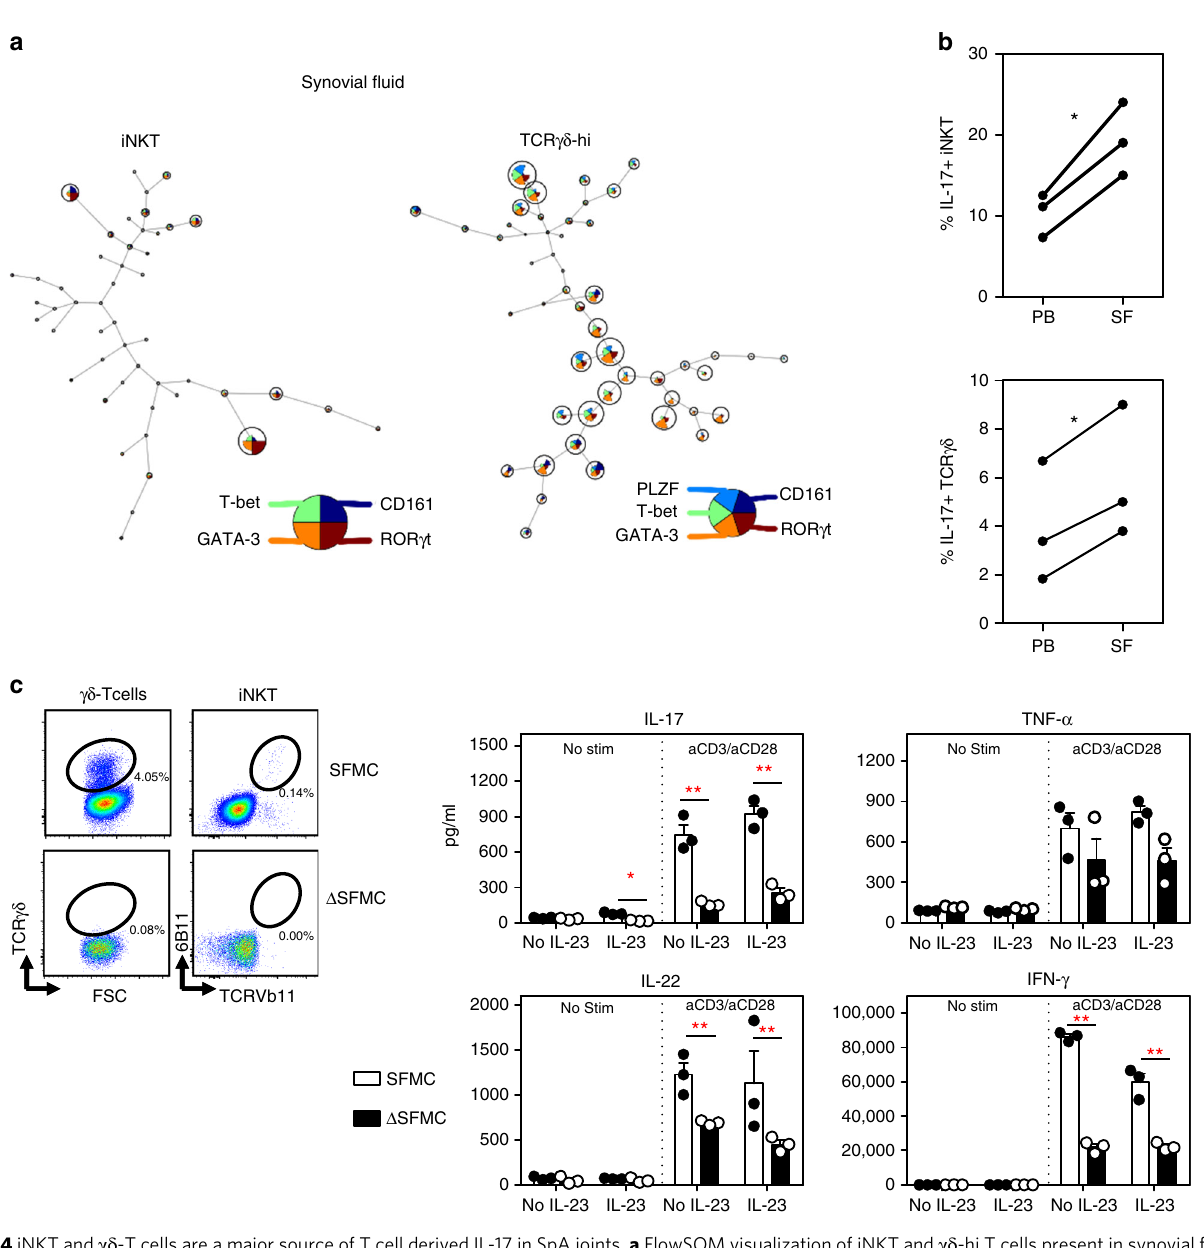
Fig. 4 iNKT and γδ -T cells are a major source of T cell derived IL-17 in SpA joints. a FlowSOM visualization of iNKT and γδ -hi T cells present in synovial fl uid samples from three treatment naïve SpA patients, stained for the indicated markers set (as explained in Fig. 3F). Nodes show cell subsets (including ROR γ t + cells) enriched in the synovial fl uid (compared to cells from paired blood samples). Other subsets (nodes) are present but at a relatively lower frequencies. b Paired analyses of IL-17 production by SpA SF and blood derived iNKT and γδ -T cells as determined in Fig. 3G. (* p < 0.05, paired t -tests). c Synovial fl uid derived mononuclear cells (SFMC) and SFMC cells depleted of iNKT and TCR γδ cells ( Δ SFMC, illustrated in the plots) were cultured in the presence or absence of IL-23 combined with or without aCD3Ab/aCD28Ab stimulation. Supernatants were collected at 72 h of culture and cytokines production was measured by ELISA (SFMC vs. Δ SFMC; * p < 0.05, ** p < 0.01 two-way ANOVA). Results from one experiment are shown (Representative for a total of three independent experiments using SF samples from 3 SpA patients). SFMC data (white bars), Δ SFMC (black bars). Data throughout this fi gure are presented as mean ± Next, differentially expressed genes in SpA vs. RA derived cells were evaluated and volcano plots were generated showing genes We sorted peripheral blood iNKT and TCR γδ T cells next to (red dots) at least 2 fold upregulated in either SpA or RA CD161 − Tconv cells from 7 SpA and 5 RA patients prior to gene (adjusted p < 0.05) (Fig. 5e). Pairwise comparison of iNKT, γδ -T expression pro fi le analyses. Principal component analysis (PCA) cells and Tconv of SpA and RA patients indicated 1594, 168, and of normalized transcriptomics data showed separate clustering of 1206, respectively, differentially expressed genes. When compar- iNKT cells of RA patients and SpA patients and to a lesser extent ing cells from SpA and RA patients, we detected no signi fi cant also for γδ -T cells and Tconv cells indicating clear differences in differences in expression of the Th cell signature transcription gene expression pro fi les between SpA and RA patients (Fig. 5d). factors, RORC (Th17), TXB21 (Th1) or GATA3 (Th2) , for any of